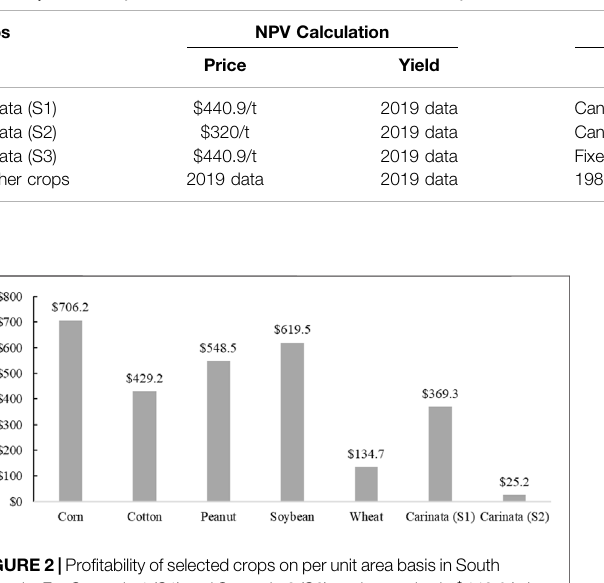
TABLE 2 | Price and yield status in NPV calculations and risk analysis for carinata scenarios and all other crops.